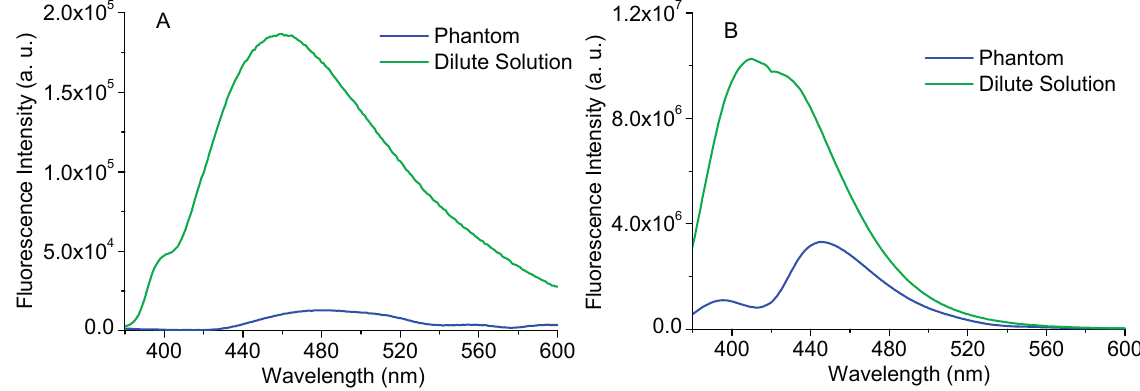
Figure 9. Comparison between the fluorescence emission spectra ( λ exc = 350 nm) of NADH (reduced form of nicotinamide adenine dinucleotide) 1.5 µg/mL ( A ) and Carbostyril 124 (7-amino-4-methyl-2(1 H )-quinolinone) 1.5 µg/mL; ( B ) in homogeneous solution and in a phantom containing 1 mg/mL of Hb (hemoglobin) and 0.15% w/v (weight/volume) of polystyrene